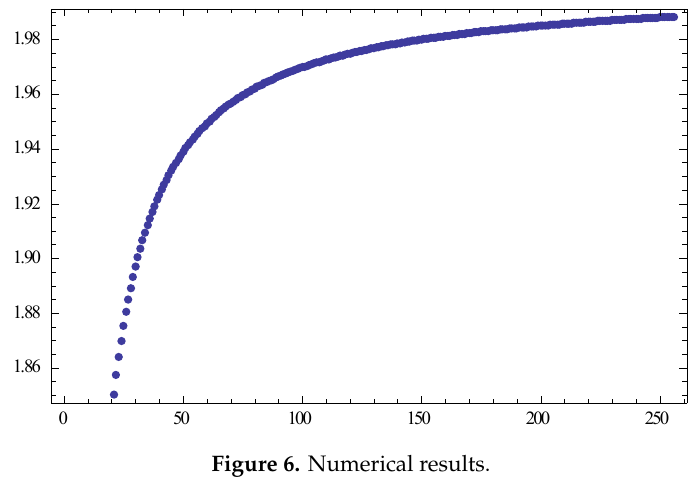
Figure 6. Numerical results.